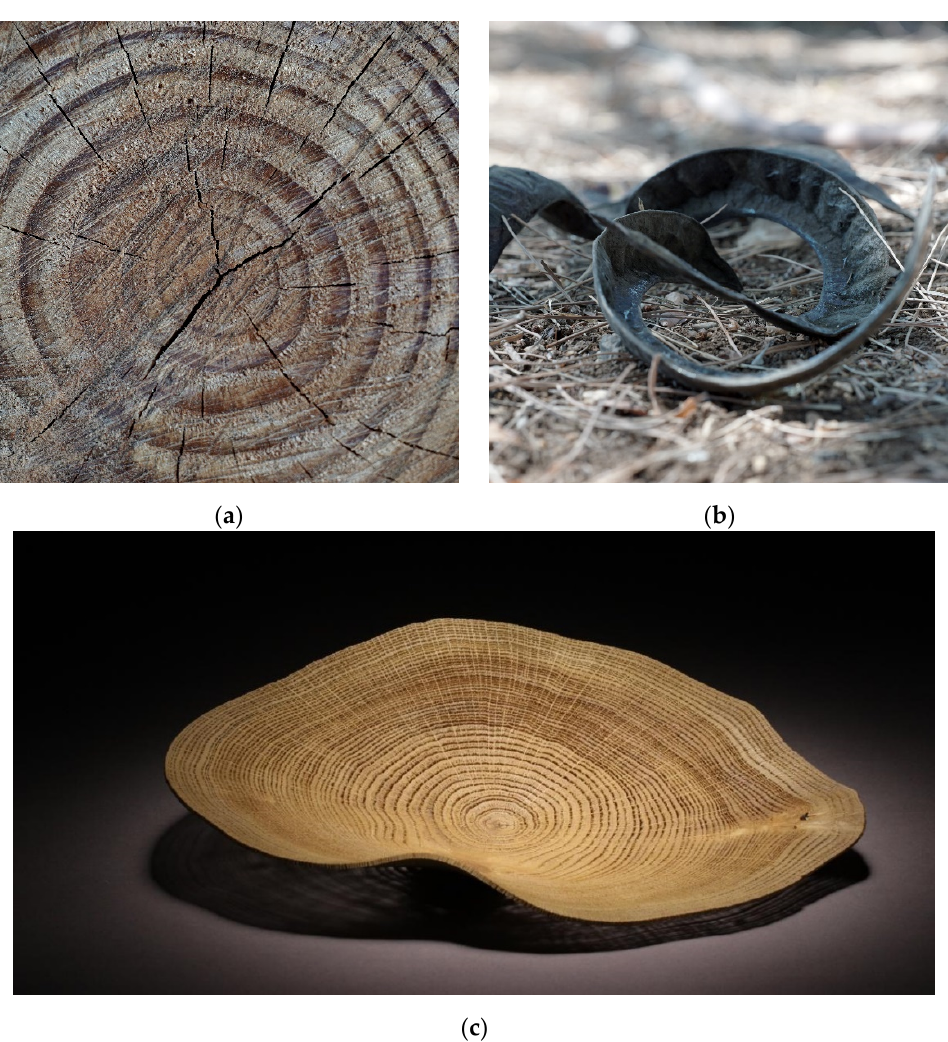
Figure 1. Examples of shrinking-induced shape changes in drying natural materials. ( a ) Crack propagation in Pinus halepensis tree trunk due to volume decrease by water evaporation in a cylindrical geometry constrain. ( b ) Delonix regia seed pod twists into a chiral shape. ( c ) A drying thin slice of an oak tree trunk buckles out-of-plane releasing the internal stresses instead of breaking (credit: Pascal Oudet [7]).